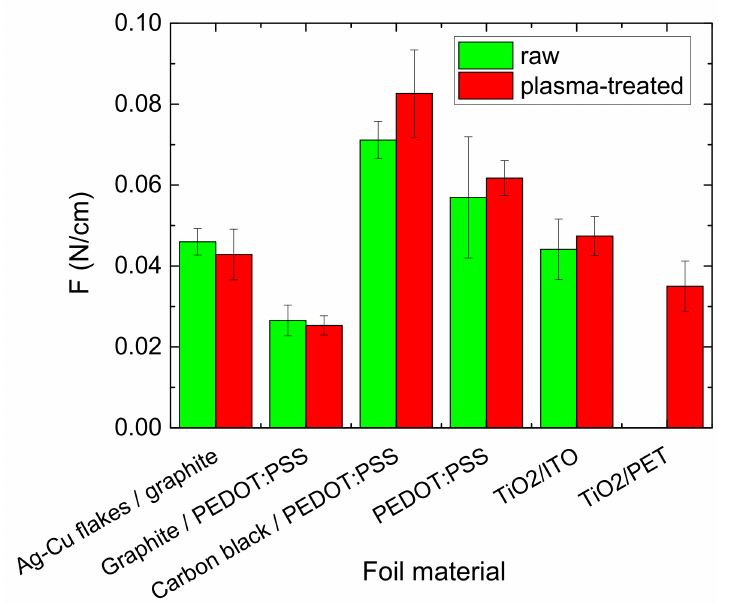
Figure 1. Adhesion forces of nanofibers electrospun onto foil substrates, with and without a preceding plasma treatment of the